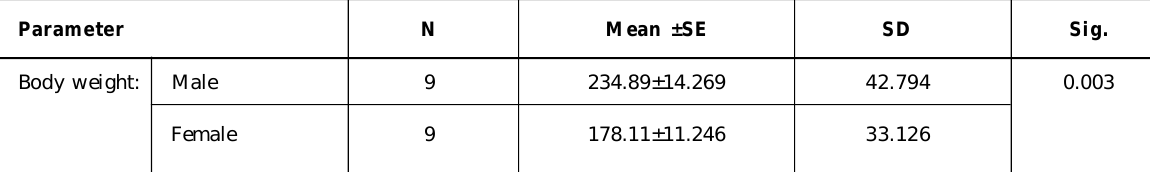
Table 2: Mean ± SE of body weights of rats after administration of aqueous extract of E. indica Parameter N Mean ±SE SD